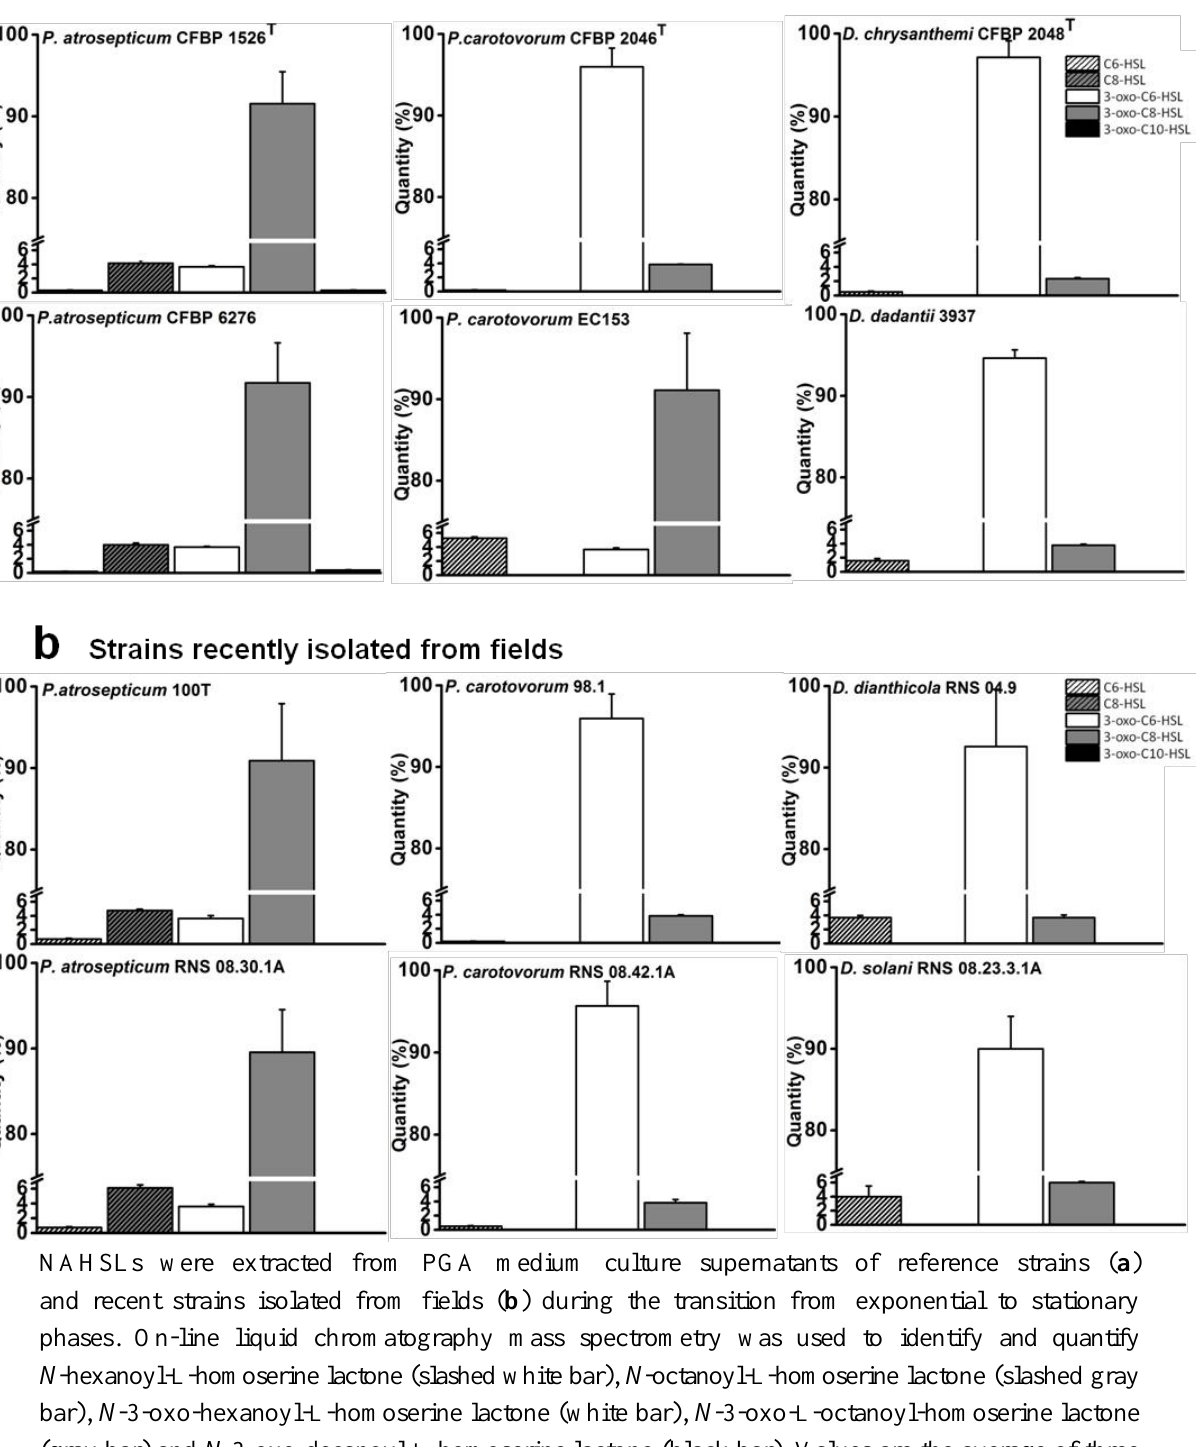
Figure 1. Abundance and diversity of N -acyl homoserine Lactone molecules produced by Pectobacterium and Dickeya